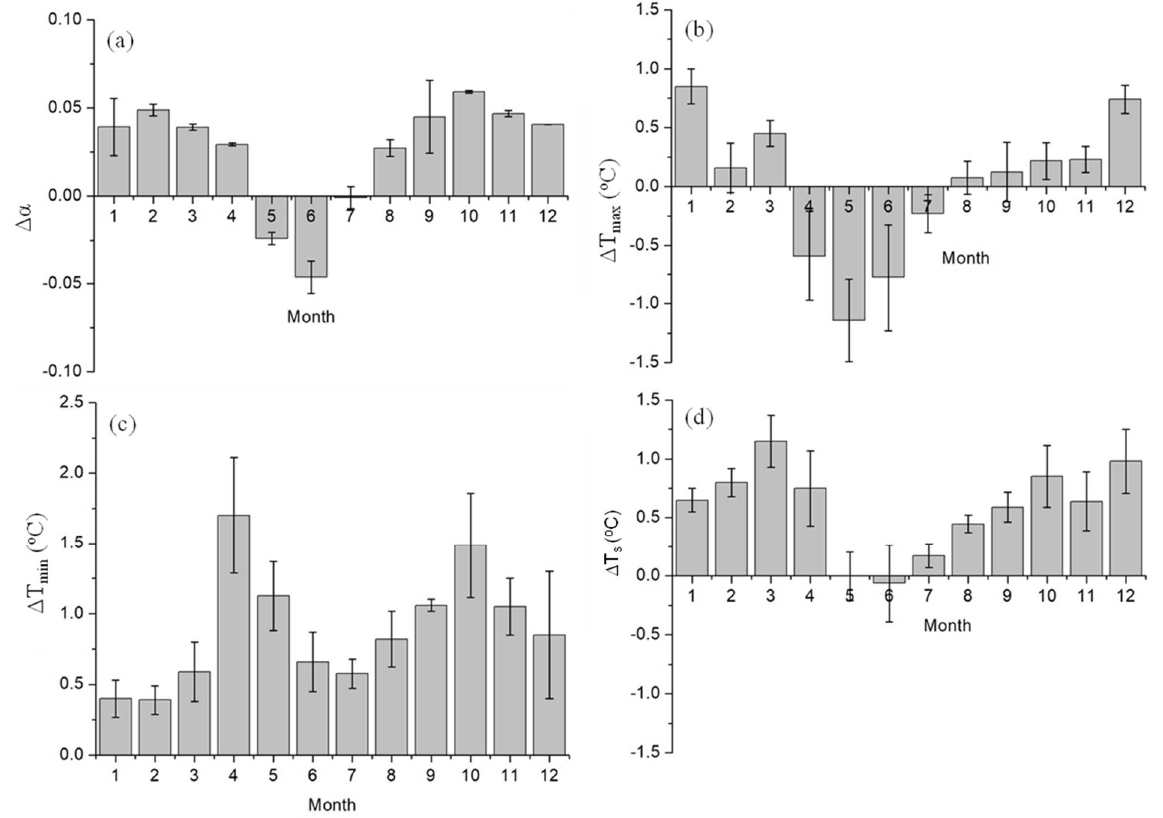
Figure 7. Seasonal perturbations of monthly ∆ α ( a ), ∆ T max ( b ), ∆ T min ( c ) and ∆ T s ( d ) values between paddy fields and the temperate deciduous forest in South Korea. Datasets used were averaged over four years 2011–2014.